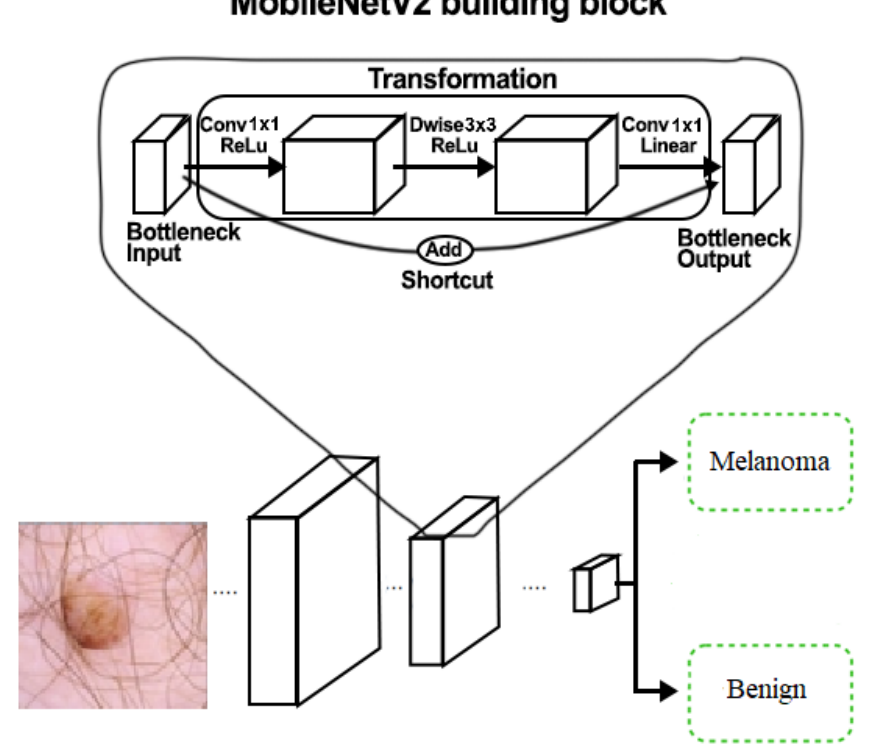
Figure 5. Classifier based on